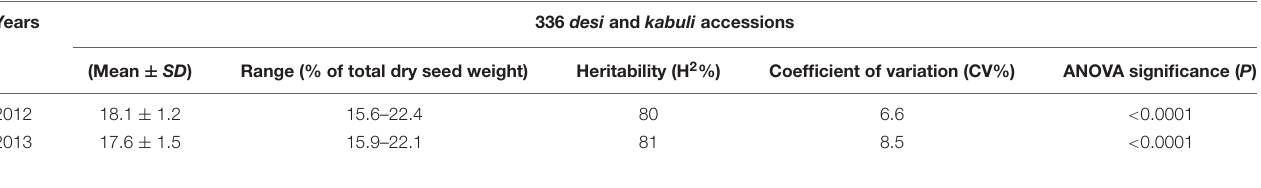
TABLE 1 | Diverse statistical measures estimated for seed-protein content variation observed in a chickpea association panel. Years 336 desi and kabuli accessions (Mean ± SD ) Range (% of total dry seed weight) Heritability (H 2 %) Coefficient of variation (CV%) ANOVA significance ( P